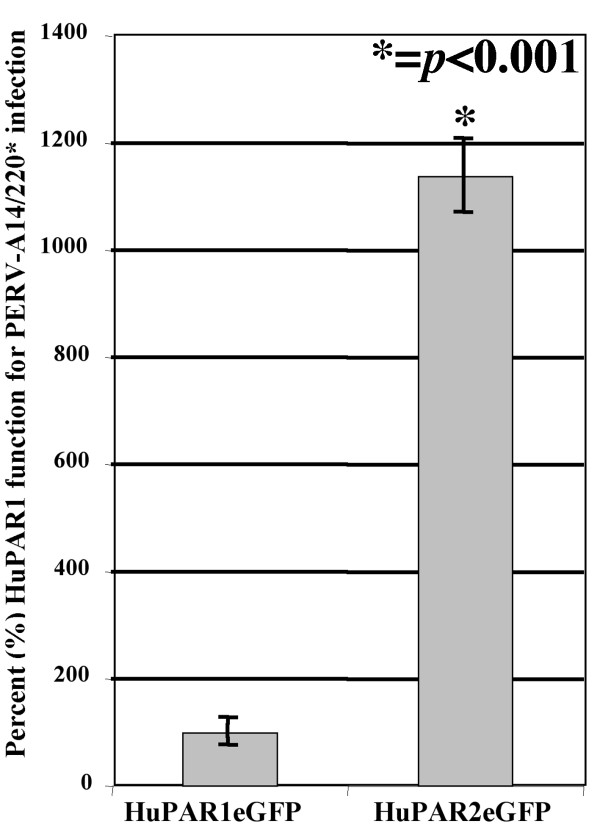
HuPAR1 and HuPAR2 function for PERV-A 14/220* infection. HuPAR1 and HuPAR2 C-terminally tagged eGFP constructs were expressed in non-permissive SIRC cells. Stable lines were sorted by eGFP expression to yield cell populations with similar receptor expression levels. PERV pol copy number in 250 ng genomic DNA of infected SIRC/receptor-expressing cell lines was determined to assess receptor function. HuPAR2 PERV pol copy number was normalized by HuPAR1 PERV pol copy number in each experiment and expressed as percent of HuPAR1 function. The average function determined by three individual infection experiments with three replicates each is shown with standard errors. HuPAR2 is 11-fold more functional than HuPAR1 (p < 0.001).